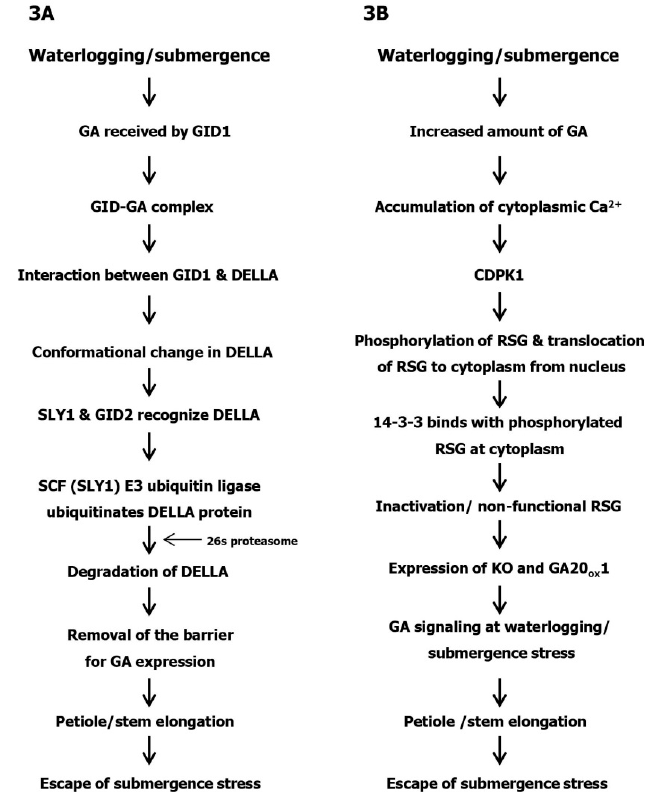
Figure 3. DELLA-dependent and -independent GA signaling in plants under submergence stress conditions. ( 3A ) DELLA-dependent escape strategy in plants; GID-GA complex makes conformational change in DELLA. After that SCF ubiquitinates DELLA protein which induces GA expression for petiole/stem elongation. ( 3B ) DELLA-independent escape strategy in plants; Ca 2+ accumulation enhances CDPK1 production for the phosphorylation of RSG to translocate it into the cytoplasm from nucleus. 14-3-3 inactivates RSG as a GA-mediated submergence escaping strategy. CDPK1: Ca2+-dependent protein kinase 1; DELLA: N-terminal D-E-L-L-A amino acid sequence; GA: Gibberellins; GA20ox1: GA 20 oxidase1; GID1: Gibberellin-insensitive dwarf 1; GID2: Gibberellin-insensitive dwarf 2; RSG: Repression of shoot growth; SCF: Skp1, Cullin, F-box; SLY1: